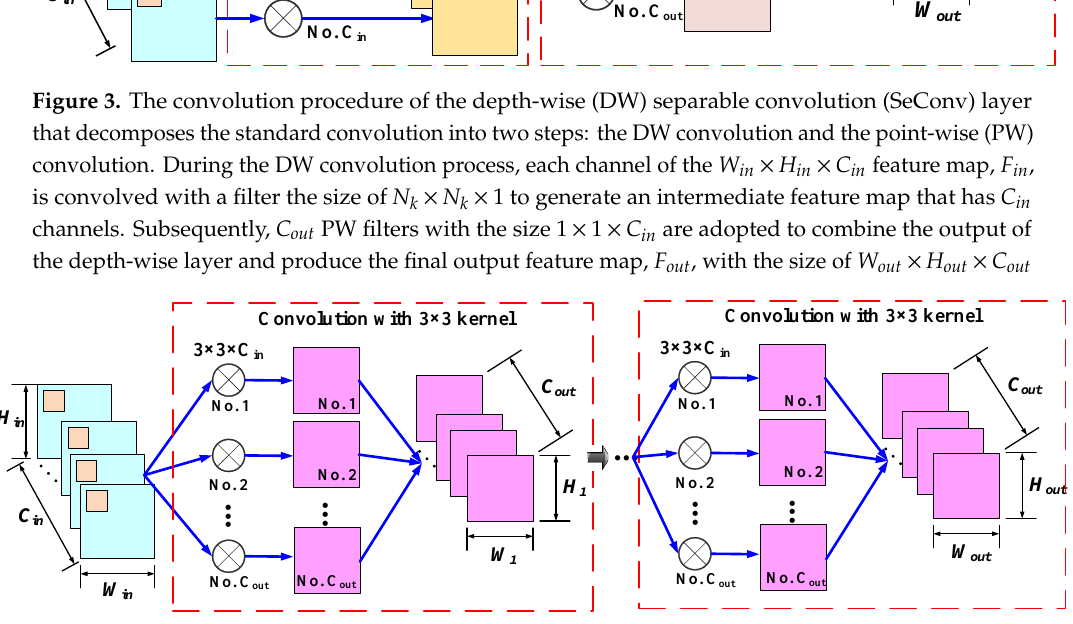
Figure 4. The procedure of the kernel decomposition convolution layer that decomposes the large convolution kernels into 𝑀 stacked 3 × 3 filters. Given the 𝑊 𝑖𝑛 × 𝐻 𝑖𝑛 × 𝐶 𝑖𝑛 feature map, 𝐹 𝑖𝑛 , 𝐶 𝑜𝑢𝑡 small convolution kernels with the size of 3 × 3 × 𝐶 𝑖𝑛 are applied to generate the first intermediate feature map with the size of 𝑊 1 × 𝐻 1 × 𝐶 𝑜𝑢𝑡 . Subsequently, the first intermediate feature map is convolved successively with 𝐶 𝑜𝑢𝑡 small convolution kernels with the size of 3 × 3 × 𝐶 𝑜𝑢𝑡 for 𝑀 − 1 times, and the output feature map 𝐹 𝑜𝑢𝑡 with the size of 𝑊 𝑜𝑢𝑡 × 𝐻 𝑜𝑢𝑡 × 𝐶 𝑜𝑢𝑡 is produced.